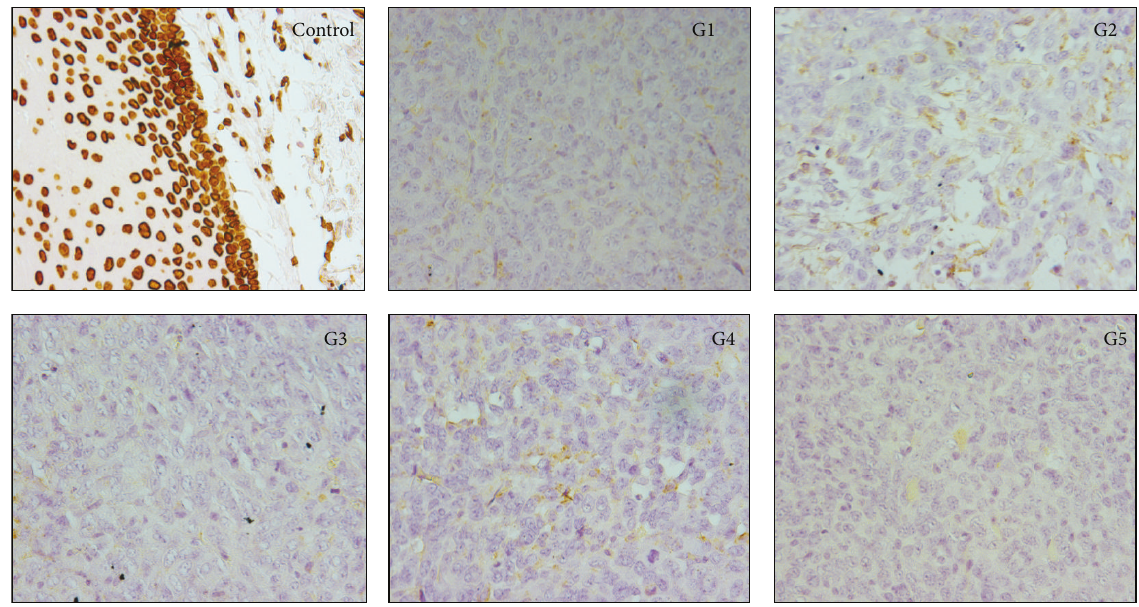
Figure 5: Human nuclei analysis in primary murine breast tumors, using the human specific antibody anti-lamin A + C, in G1 to G5 groups. Primary tumors were collected 15 days after tumor cell inoculation. Positive control (human tissue), showing positive staining. Slide of one representative animal of each group is shown. The antibody did not stain any structure in all primary tumors analyzed.